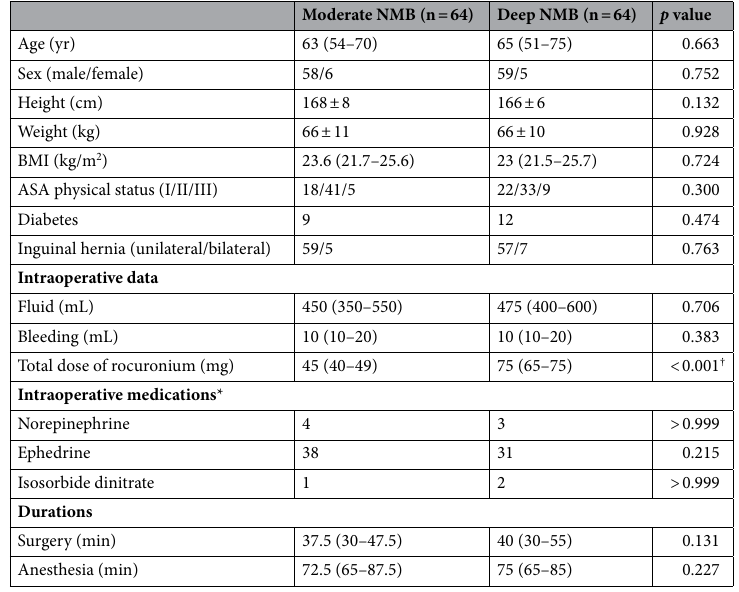
Table 1. Patient characteristics and operative data. Values are presented as the mean ± standard deviation, median (interquartile range), and number of patients. NMB, neuromuscular block; BMI, body mass index; ASA, American Society of Anesthesiologists. *Number of patients receiving vasoactive drugs. † p value < 0.05 between-group comparison.